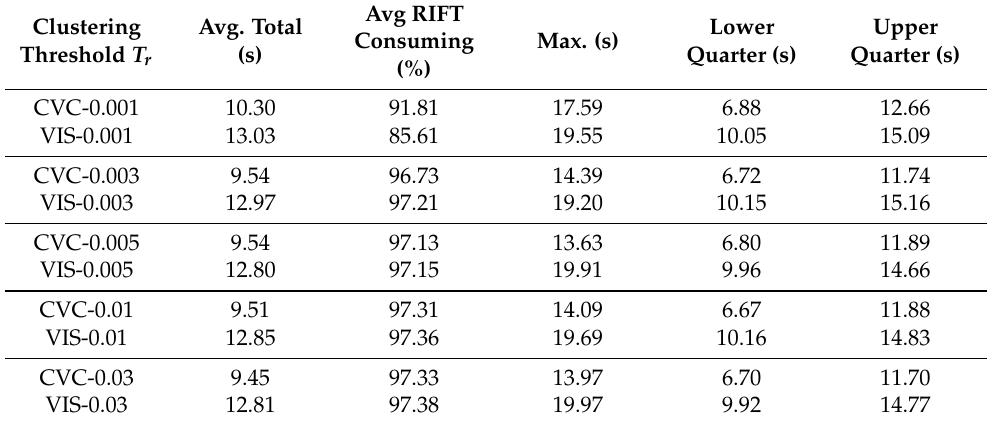
Table 3. Time consumption analysis of PC-MLH with different clustering thresholds T r .